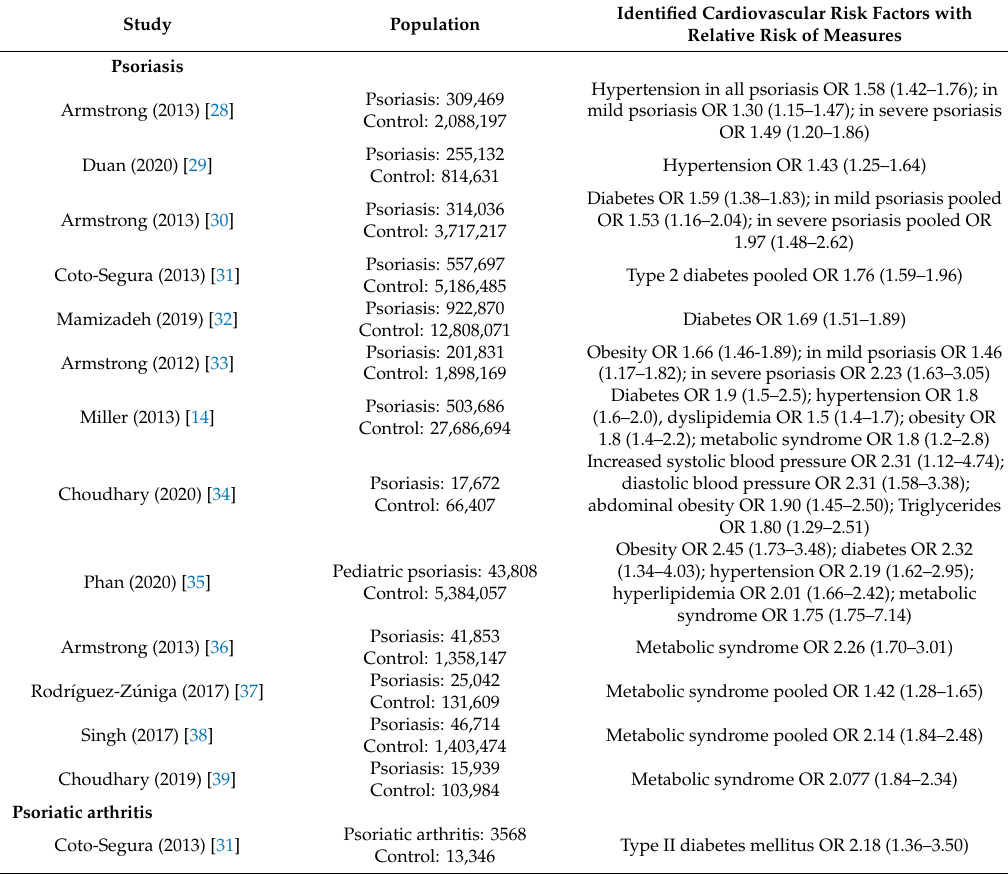
Abbreviation: OR, odds ratio. Values in brackets indicate 95% confidence